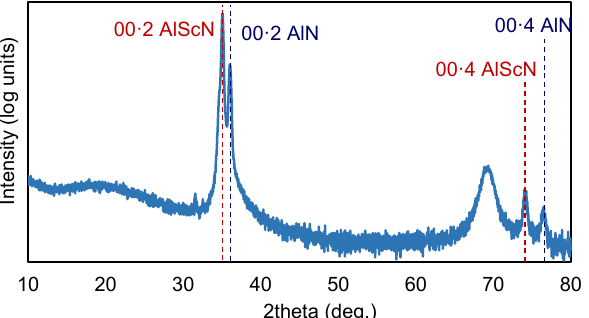
Figure 8. Typical XRD pattern of Al 0.7 Sc 0.3 N/AlN/Si structure in log units to highlight the absence of 10 ∙ 1, 10 ∙ 2 and 10 ∙ 3 peaks.